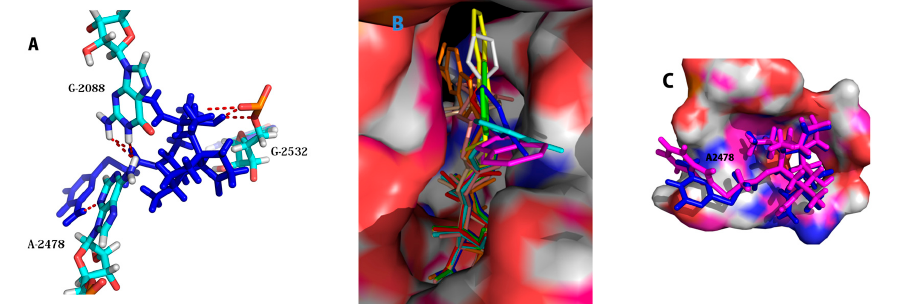
Figure 4. ( A ) Docking modes of the synthesized compounds into 5HL7. Key amino acid residues and ligand-active site interactions are shown. 3a (blue) to 5HL7; Important residues are drawn in sticks and different color. Hydrogen bonds are showed as dashed red lines; ( B ) The best pose of the compounds obtained from the docking study in the active site of the peptidyl transferase center. ( 3a blue, 3b cyan, 3c yellow, 3d magentas, 3e oranges, 3f wheat, 3g gray, 3h green, 3i salmon, lefamulin red); ( C ) 3a (blue) and 3d (magentas) in 5HL7.